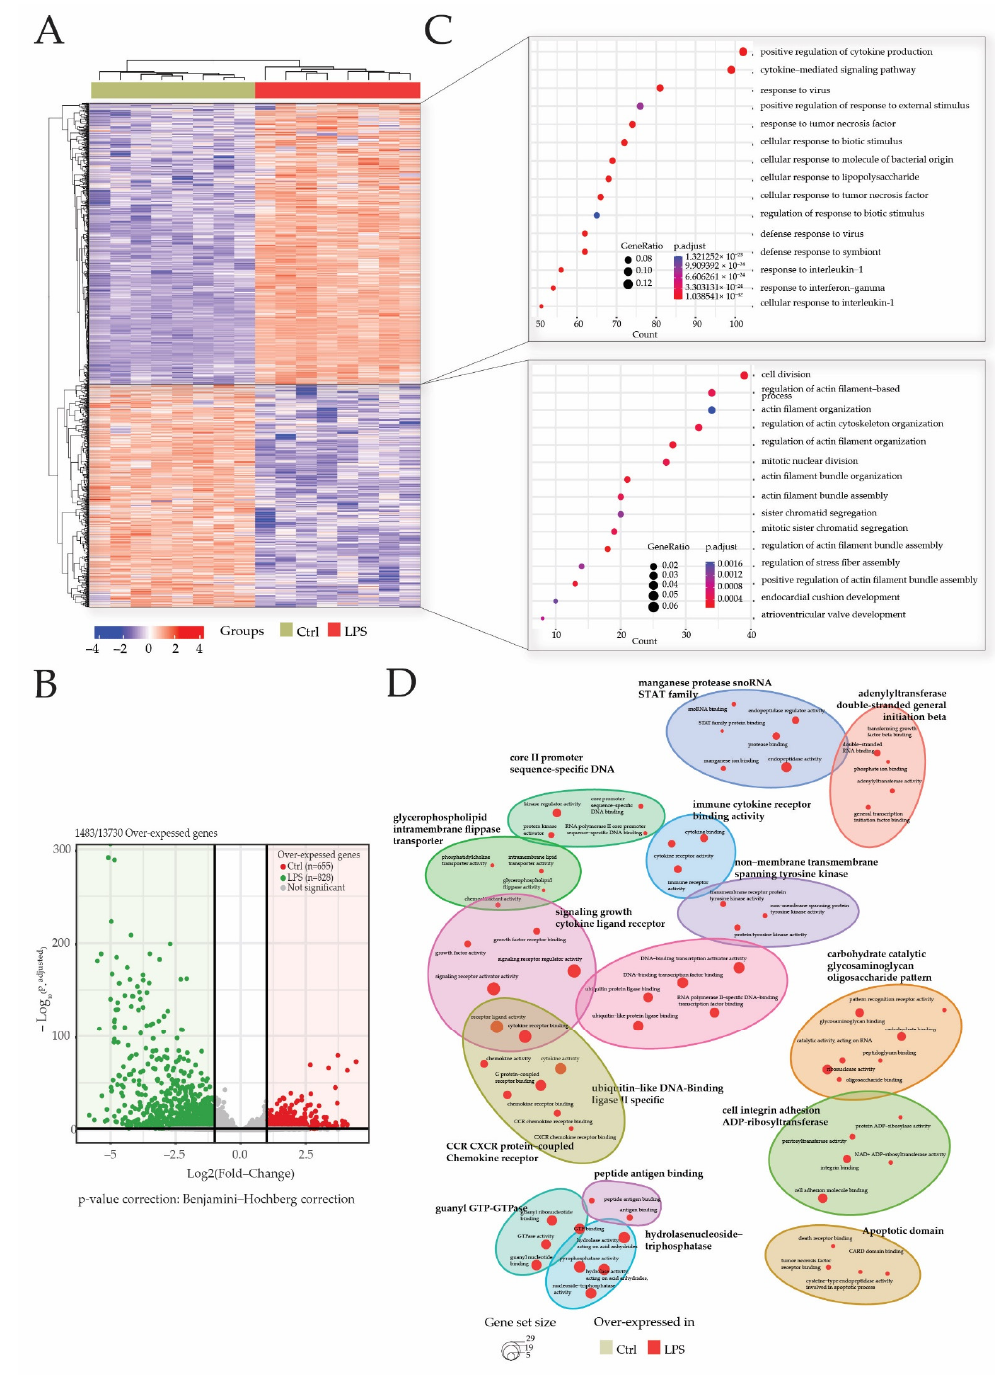
Figure 3. LPS injection promotes cytokine and inflammatory pathways. Transcriptome analyses were made from whole heart of rats injected with LPS (LPS) or saline (CTRL), and this allowed the identification of 13730 genes. Differentially expressed genes (DEGs) were selected by their fold change of expression (log2Ratio(LPS/CTRL) >1 or (log2Ratio(LPS/CTRL) > − 1 and an adjusted p value < 0.05 using the R package “Deseq2”. Heatmap visualization ( A ) of the 1483 DEGs showed that groups were well clustered and revealed two main clusters of overexpressed genes, respectively, in the LPS group and CTRL group. Log 10 (p.adjusted) and log2FoldChange of these DEGs are represented in the volcano plot ( B ). Gene ontology (GO) enrichments were conducted to decipher biological processes in which DEGs were mostly involved in both clusters ( C ) and within the comparison of both clustered ( D